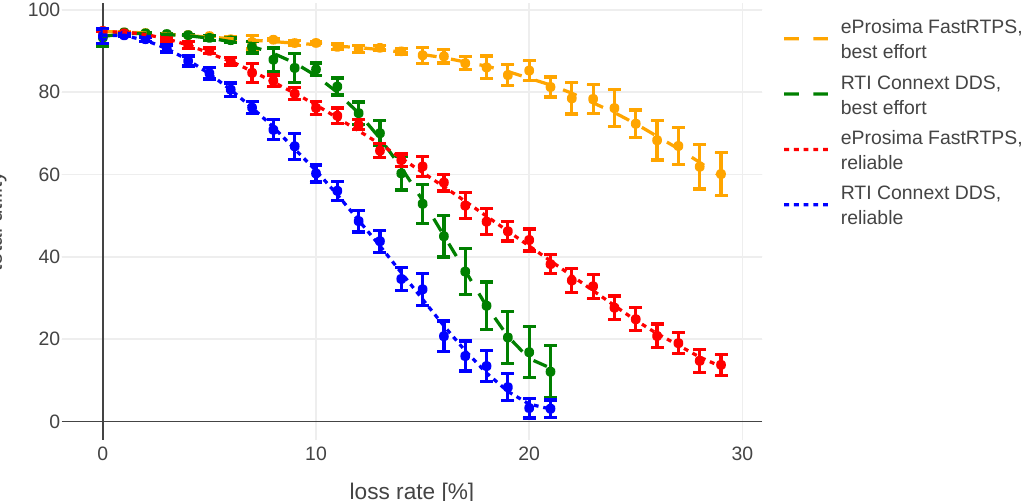
Figure 12. Total utility aggregated during the simulation of the exemplary mission (100 s) for a lossy connection. The experiments with Connext data distribution service (DDS) with loss rate higher than 21% were unfeasible, because the discovery phase was consuming most of the mission time, therefore the communication between robots was often not established at